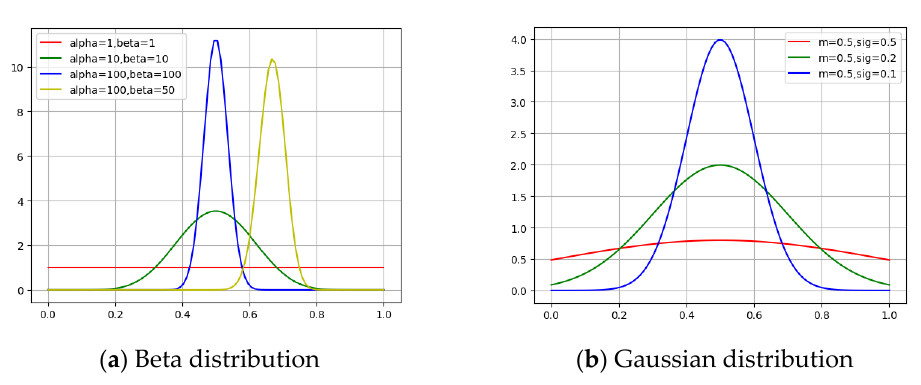
Figure 4. Different kinds of the posterior distribution of reward. Figure 4. Di ff erent kinds of the posterior distribution of